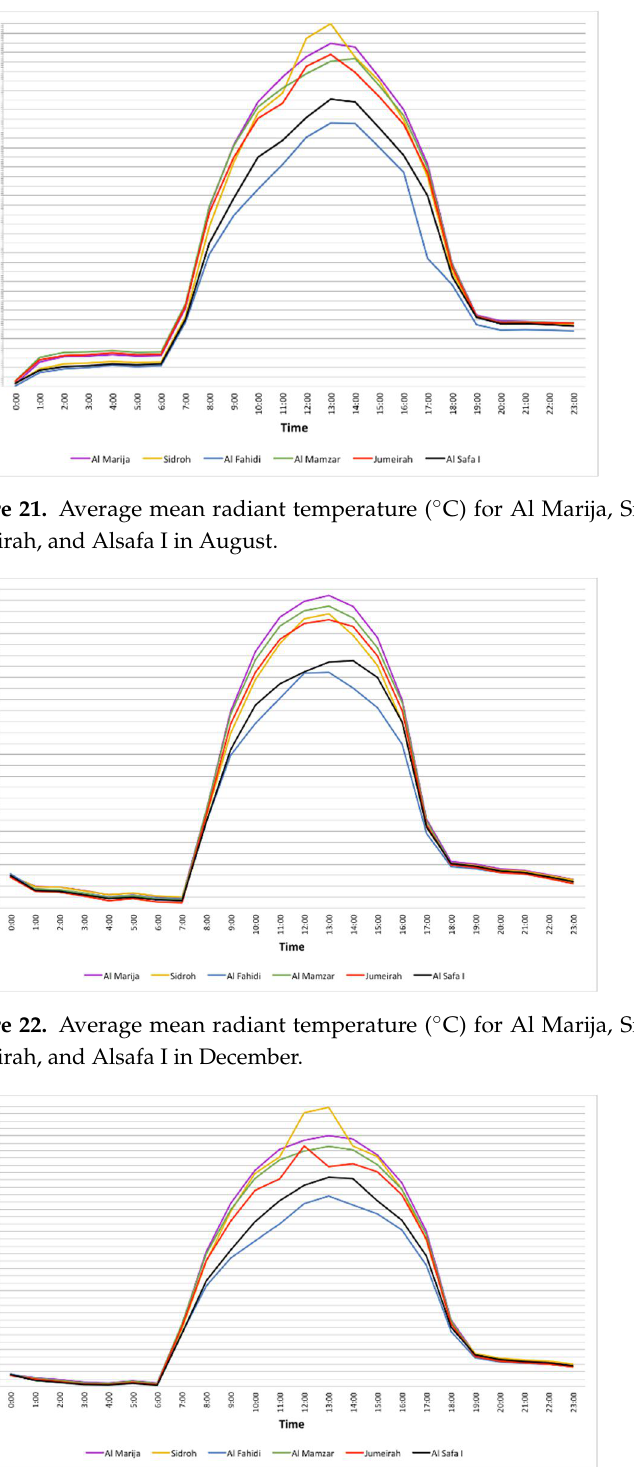
Figure 23. Average mean radiant temperature (°C) for Al Marija, Sidroh, Al Fahidi, Al Mamzar, Jumeirah, and Alsafa I in April.